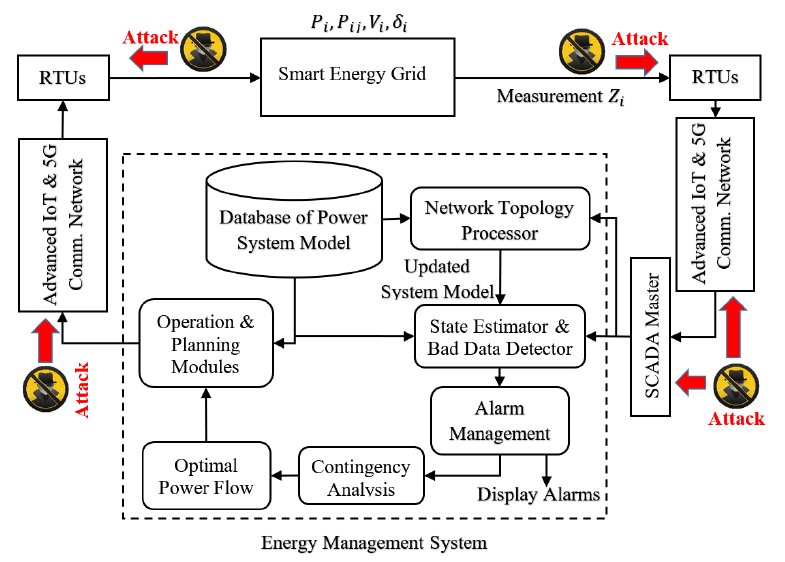
Figure 2. A supervisory control and data acquisition (SCADA)-based energy management system (EMS) representing different cyber-vulnerable